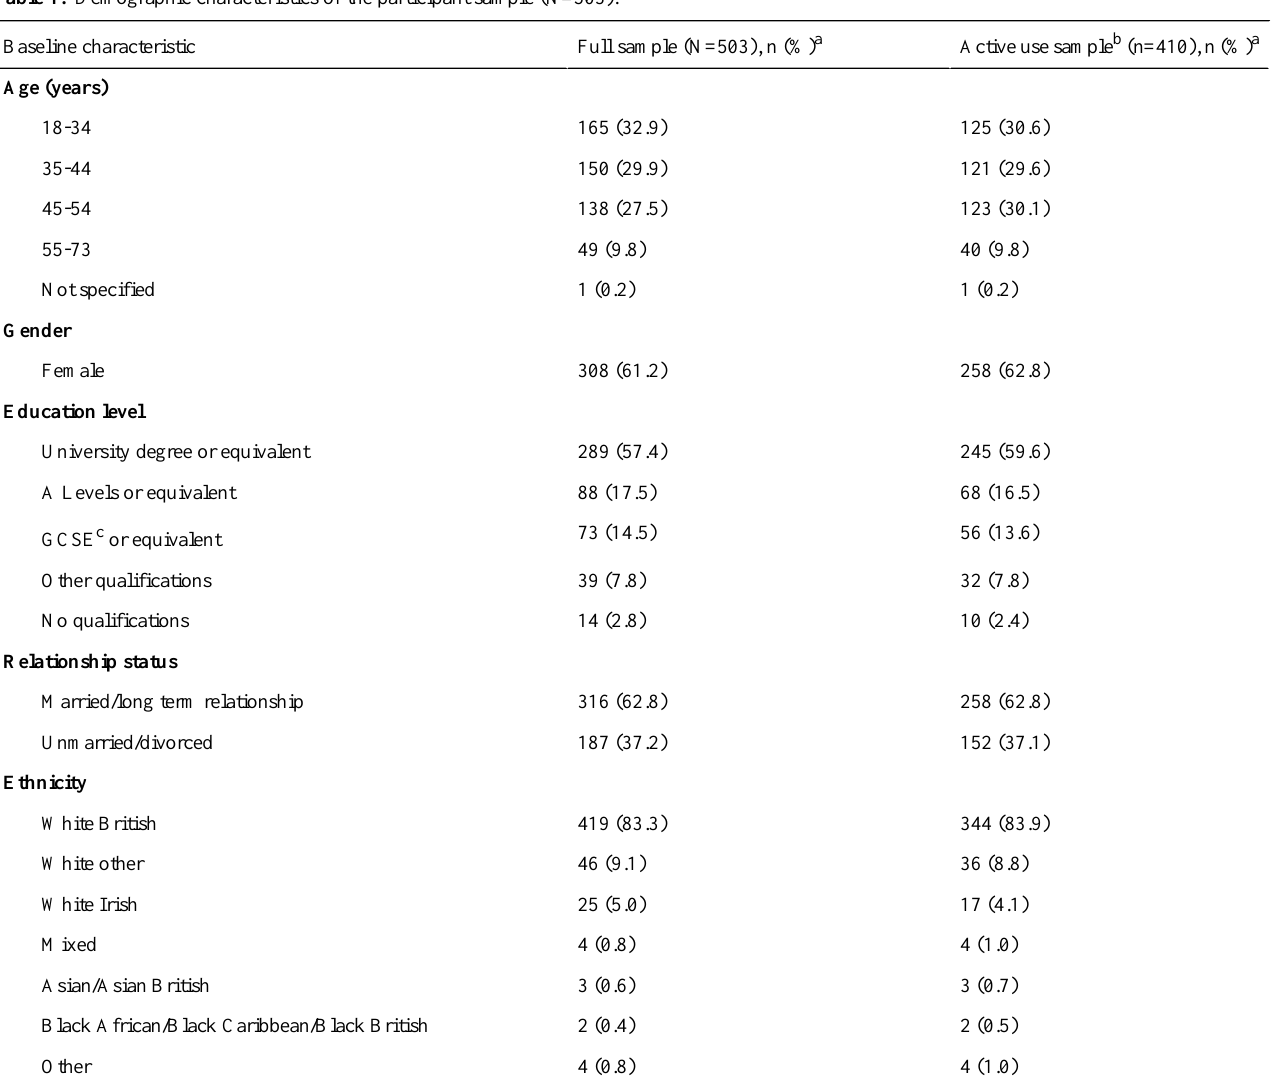
Table 1. Demographic characteristics of the participant sample